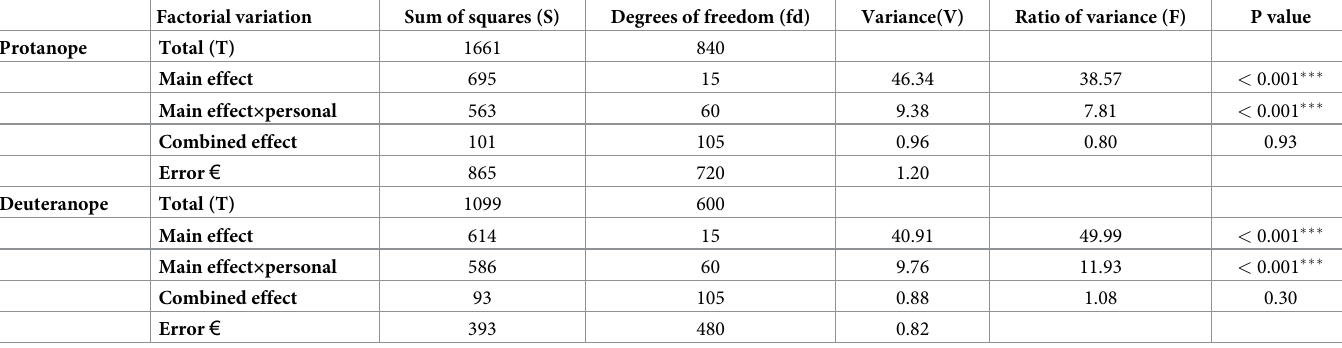
Table 4. Analysis-of-variance tables for Conspicuousness sensitivity in the protanope and deuteranope using Scheffe´’s method. Factorial